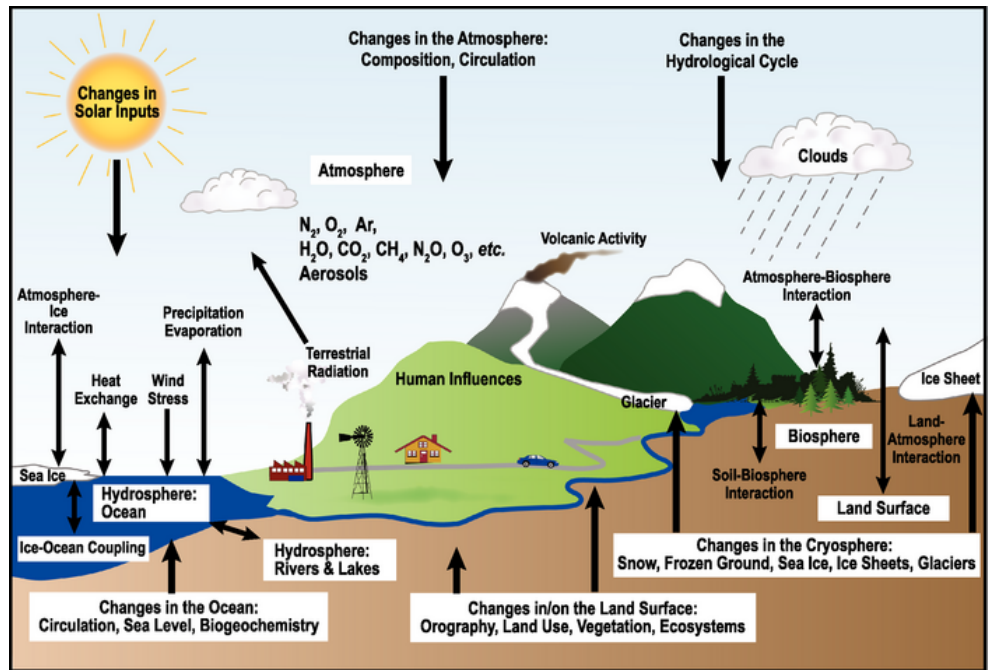
Figure 1. Schematic view of the components of the global climate system